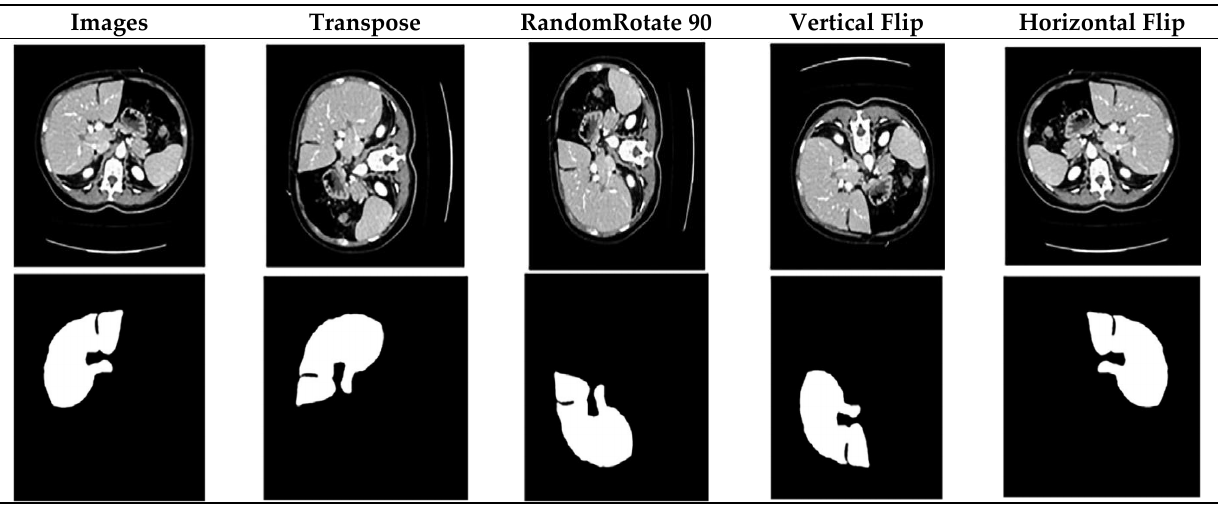
Figure 3. Effect of augmentation procedures on the unique copy.